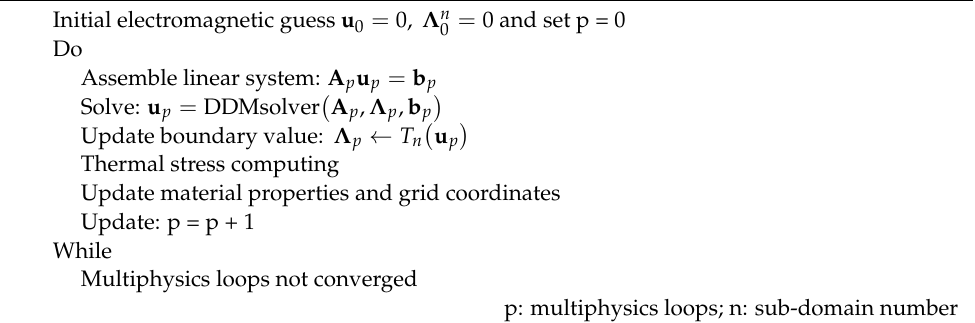
Algorithm 1. Multiphysics loops based on the domain decomposition method